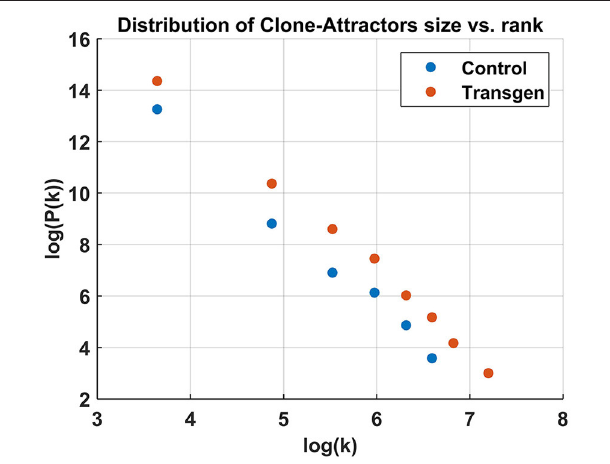
FIGURE 3 | Cluster size distribution in log-log scale, showing a power-law relation. The analysis was done for all the active CAs combined from the Control/Transgenic samples,